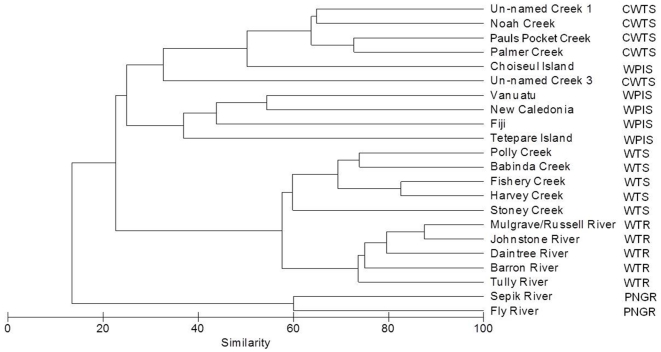
Phenogram of West Pacific freshwater fish communities.Phenogram derived from a Bray-Curtis similarity matrix of presence/absence data of freshwater fish fauna from sub-regions of the West Pacific (Key: PNGR  =  Papua New Guinea rivers, WPIS  =  West Pacific island streams, WTR  =  Wet Tropics rivers, WTS  =  Wet Tropics streams, CWTS  =  coastal Wet Tropics streams).